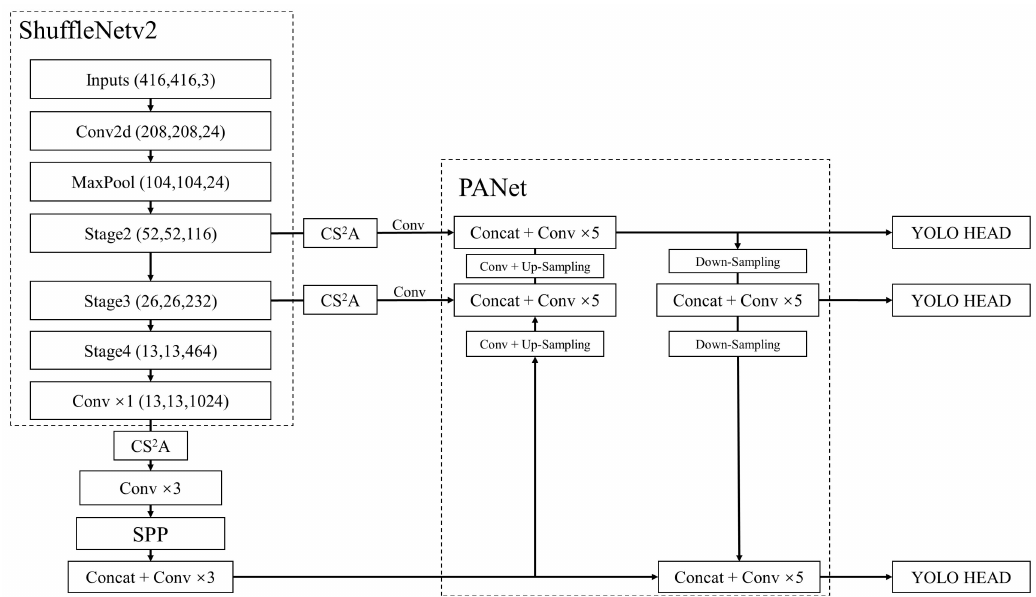
Figure 4. Overall structure of improved